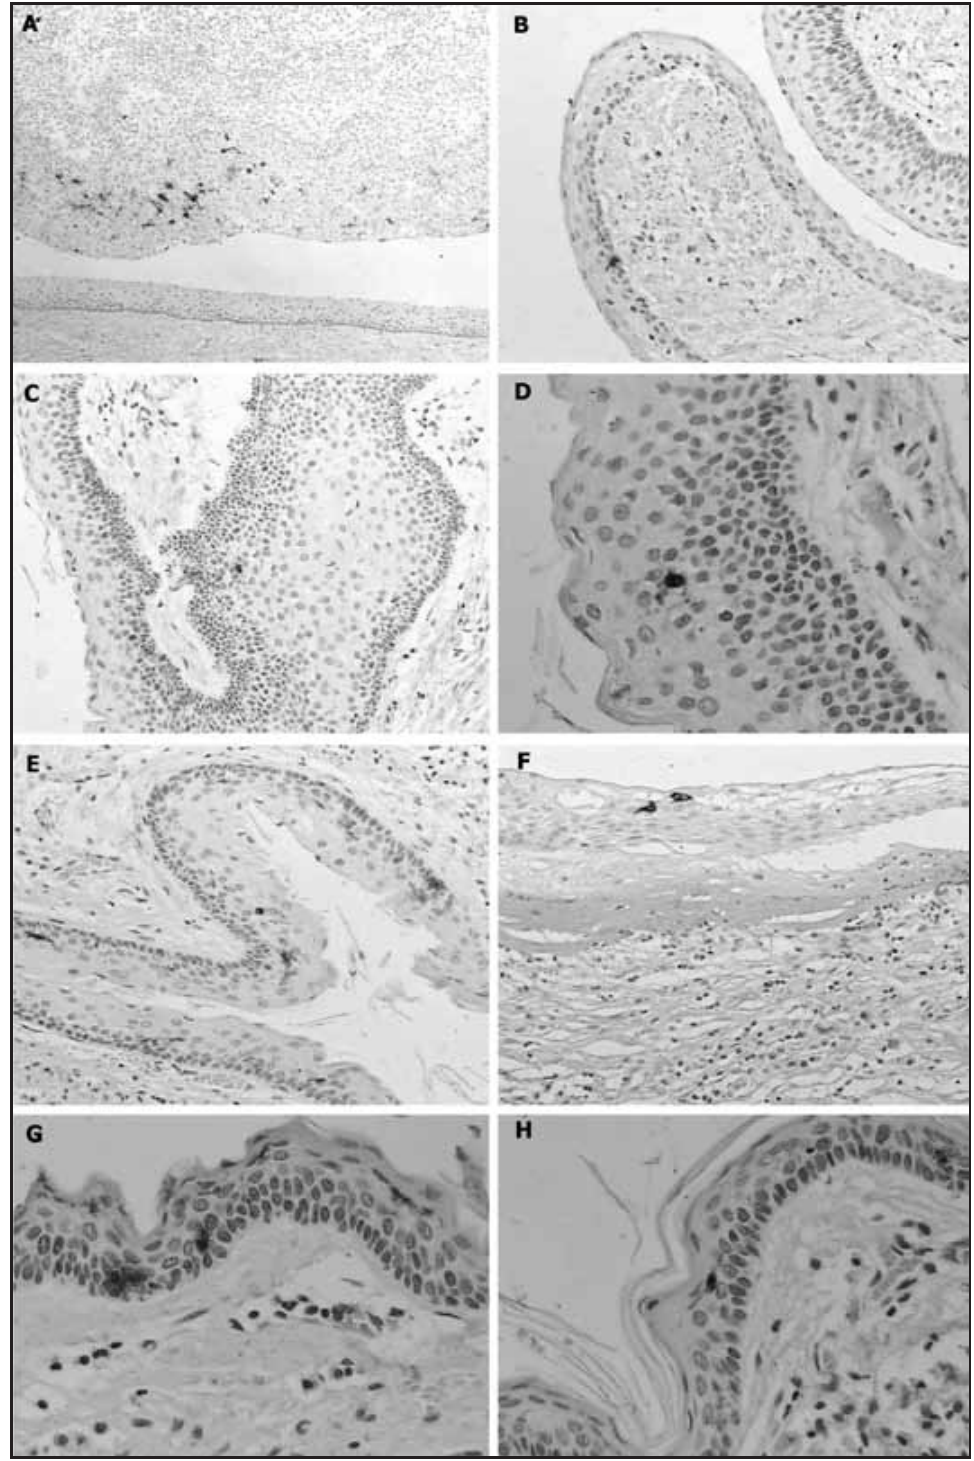
Figure 1 – Immunohistochemical expression of Langerhans cells (LCs) in keratocystic odontogenic tumors (KOTs). (A) Abundant expression of LCs in both basal and suprabasal areas. Note marked chronic inflammation in the adjacent connective tissue and absence of Langerhans cells in the epithelium cystic which covers fibrous wall without inflammation (EnVision™ System, approximately 40×); (B) dendritic cell located in the basal layer of the cystic epithelium (EnVision™ System, approximately 100×); (C) epithelial thickness exhibiting a small LC located in the intermediate layer (EnVision™ System, approximately 100×); (D) LC exhibiting round shape in the intermediate layer (EnVision™ System, approximately 200×); (E) LCs exhibiting different shapes in both basal and intermediate areas (EnVision™ System, approximately 100×); (F) dendritic cells located in the suprabasal and superficial layers. Note absence of LC in the area corresponding to the subepithelial split (EnVision™ System, approximately 100×); (G, H) Dendritic cells in different epithelial layers (EnVision™ System, approximately